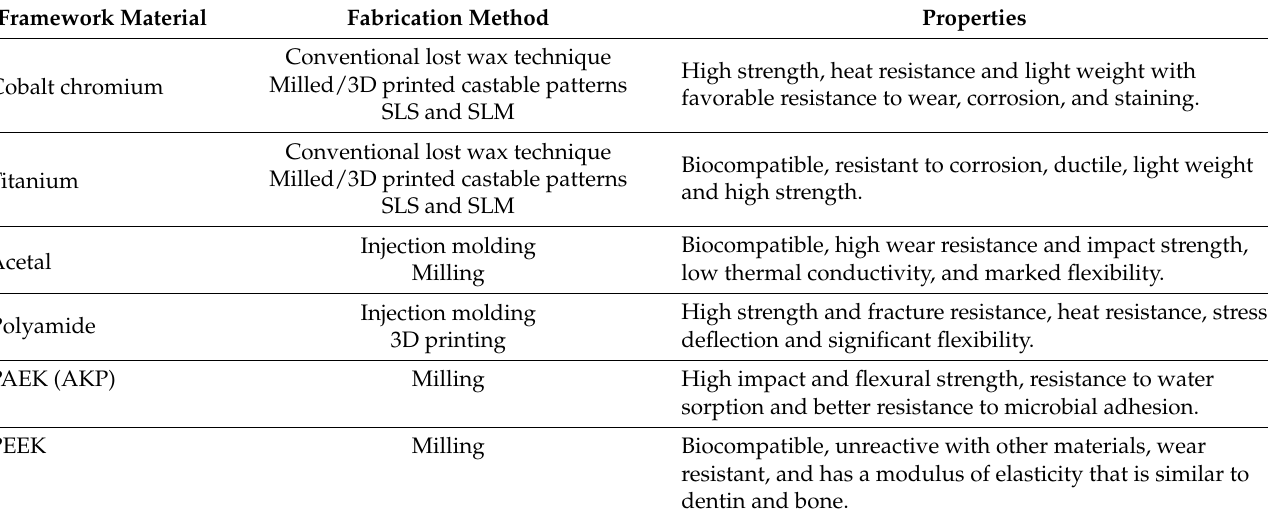
Table 1. An overview on the different removable partial denture framework materials, their method of fabrication and mechanical